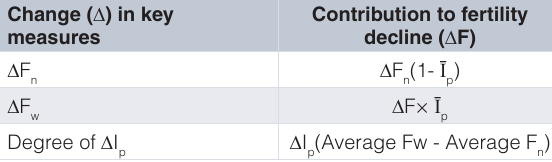
Table 4. Fertility change contribution. Change ( ∆ ) in key measures